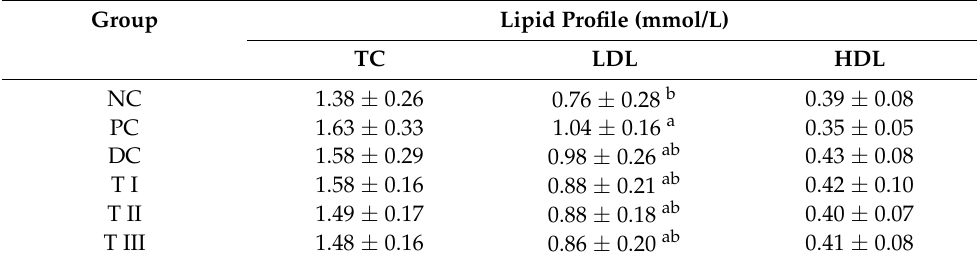
Table 3. Anti-obesity effect of E. tapos shell extract on lipid profiles.